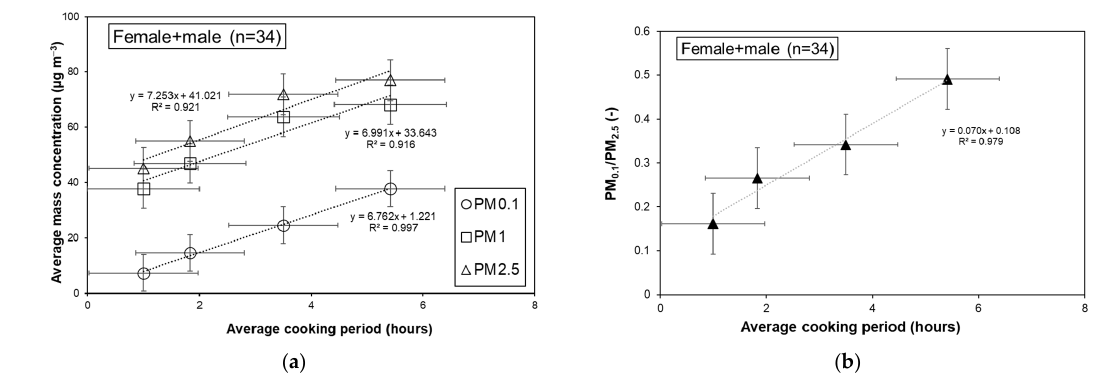
Figure 6. ( a ) Average concentrations of PM plotted against the average cooking period for male and female children; ( b ) the PM 0.1 /PM 2.5 ratios against the cooking period.